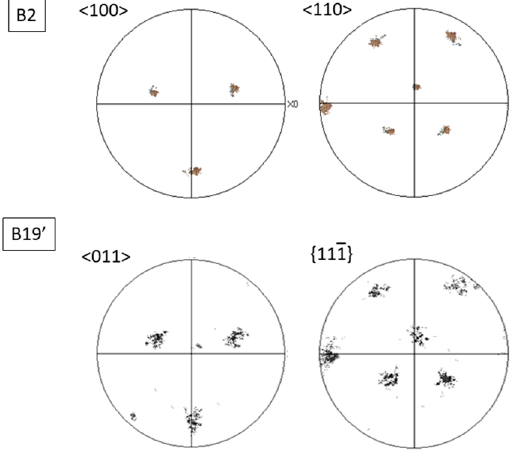
Figure 7. Pole figures obtained by selecting on the EBSD of Figure 5 a subset with the coexistence of the B2 and B19 ′ phases. The parallelisms of some B2 and B19 ′ directions or planes are shown by comparison, and can be checked by overlapping the pole figures. A specific feature in the <100> B19 ′ pole figure called “dice-5” is marked by a red circle.